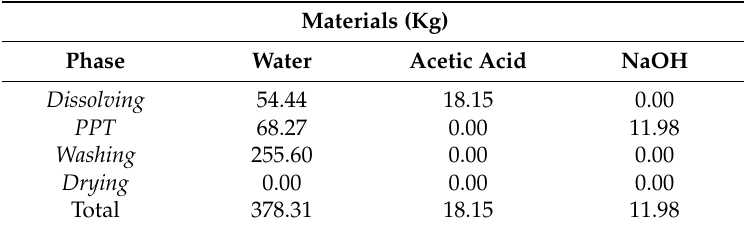
Table 2. Electricity consumption calculation for each phase of the recycling process. Equipment and